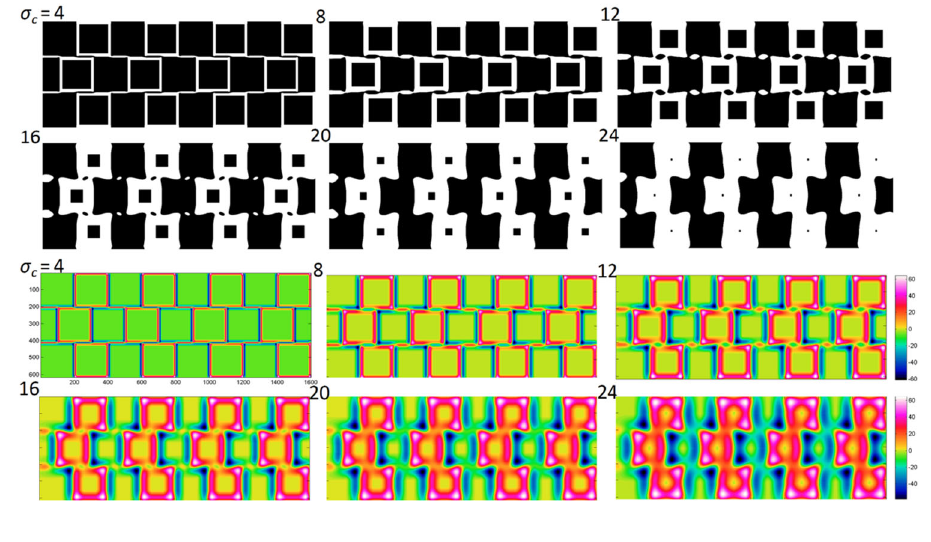
Fig. 4 Top left Munsterberg pattern with 200 9 200 px tiles. Top right Enlarged DoG output at scale 8 ( r c ¼ 8) in the edge map. Bottom The binary edge map at six different scales ( r c ¼ 4 to 24) with incremental steps of 4. Other parameters of the model are: s ¼ 2 and h ¼ 8 similar to Fig. 3 (Reproduced by permission from